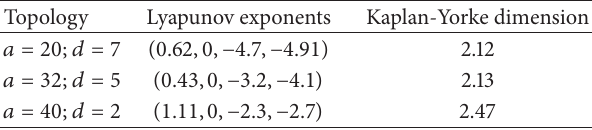
Table 3: Lyapunov exponents